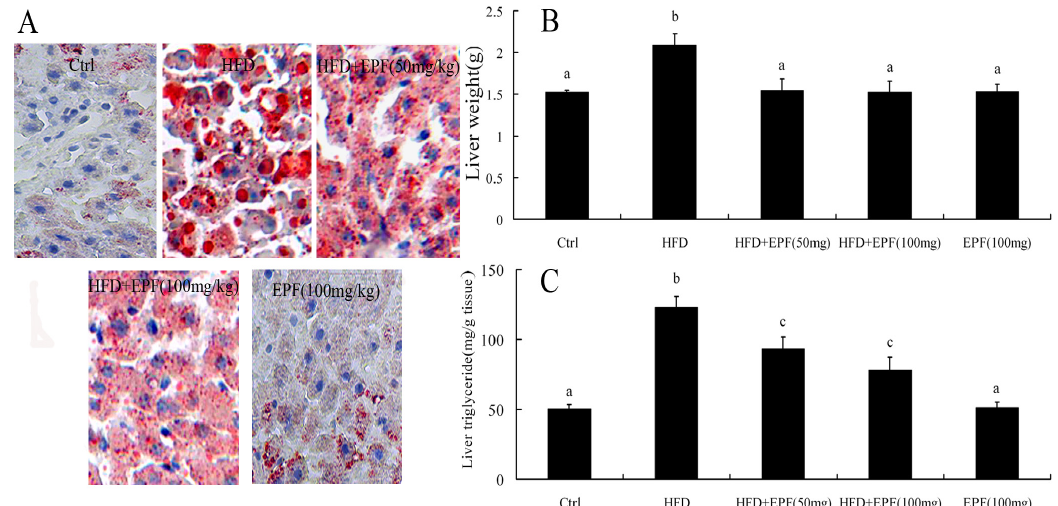
Figure 1. Hepatic lipid accumulation, liver weight and histological evaluation in mice: ( A ) the status of hepatic lipid accumulation in the different rat groups was analyzed after liver section staining with the Oil Red O method; ( B ) liver weight; and ( C ) liver triglyceride. SND, standard normal chow diet group (Control, low chow diet group); HFD, high fat diet group; HFD + EPF, high fat diet and the extracts from P. fortunei flowers (50 or 100 mg/kg). Original magnification, × 200. Significant differences among the groups were assessed by one-way ANOVA with Tukey’s post hoc test Values are mean ± the standard error of the mean (SEM) ( n = 3). Values that do not share a common superscript (a,b,c) differ significantly at p ≤ 0.05.